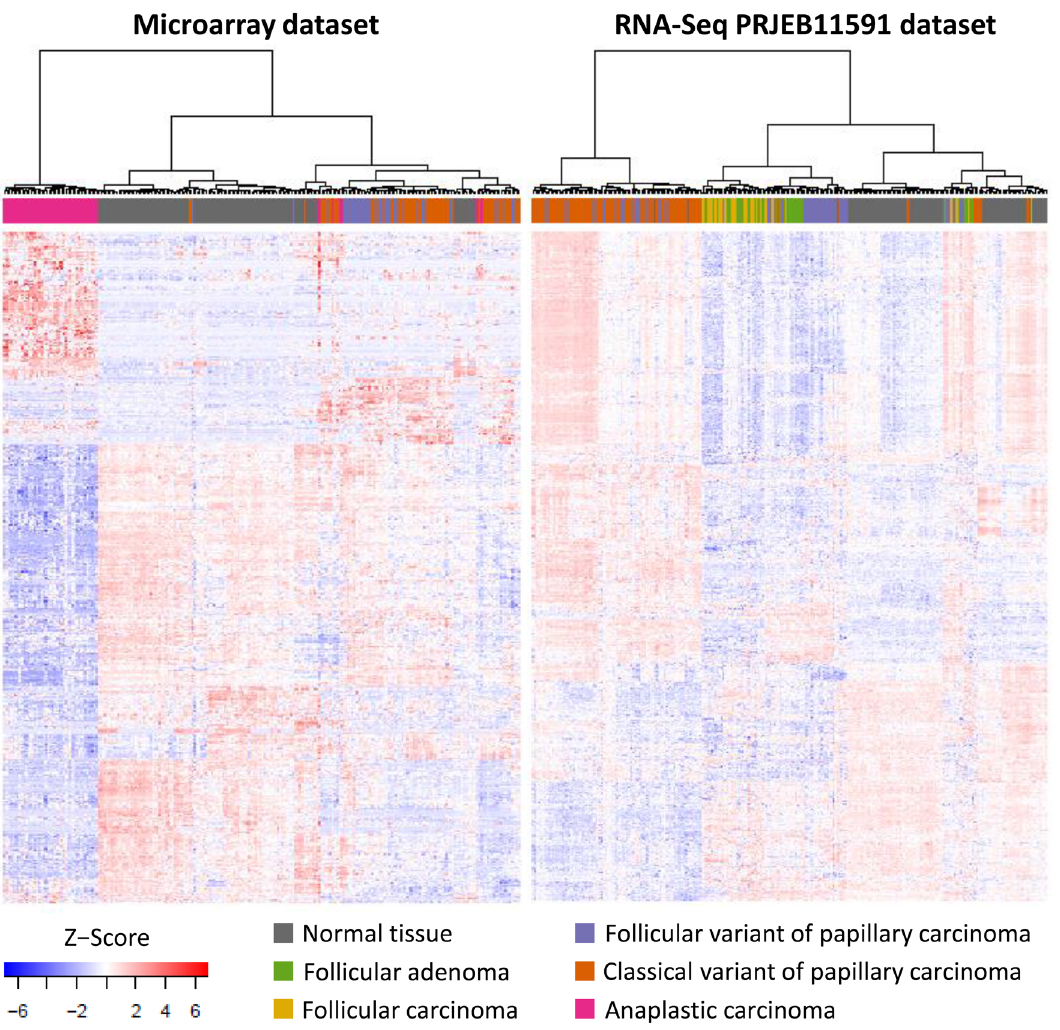
Figure 1. Clustering of FA, FTC, fvPTC, clPTC and ATC by the expression of lncRNA. ( A ) Microarray dataset; ( B ) RNA-Seq PRJEB11591 dataset. Genes differentially expressed in each histological subtype are